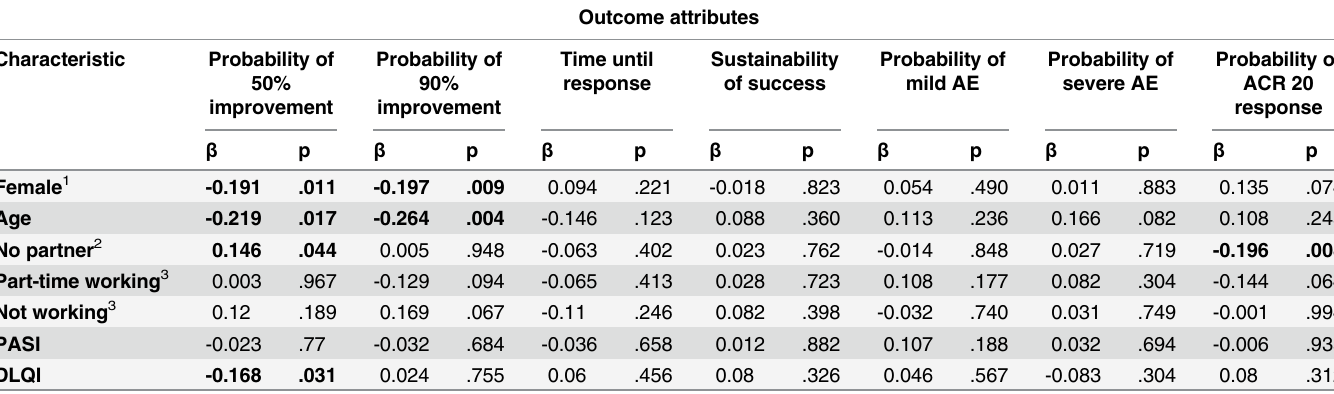
Table 4. Multivariate linear regression models for outcome attributes. Characteristic Probability of 50%